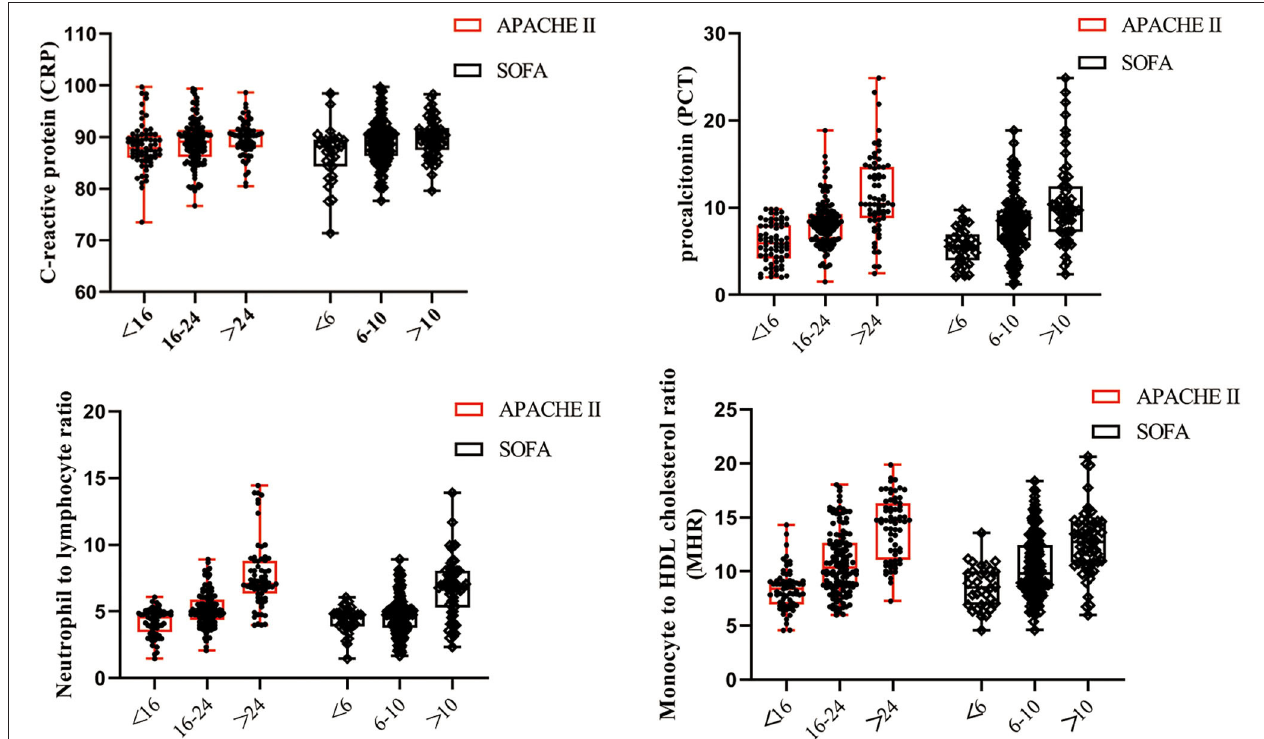
FIGURE 2 | Levels of CRP, PCT, NLR, and MHR in patients with severity classifications. Scatterplots were conducted to demonstrate the correlation between laboratory bioindicators and severity of sepsis, which was evaluated by APACHE II and SOFA scores. MHR and NLR were more closely relevant to the severity of sepsis than CRP and PCT.